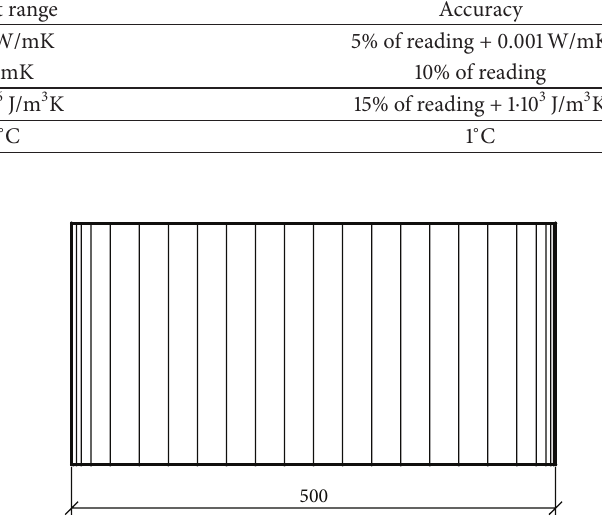
Figure 3: Finite-element scheme of the analyzed external